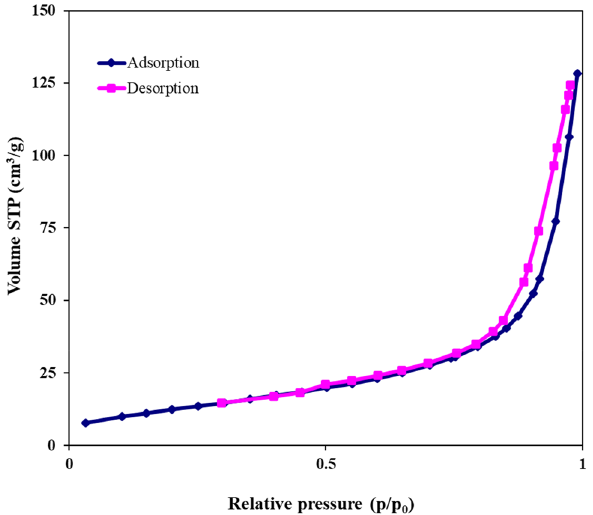
Figure 7. BET nitrogen adsorption/desorption isotherm of algal NiO nanocatalyst.